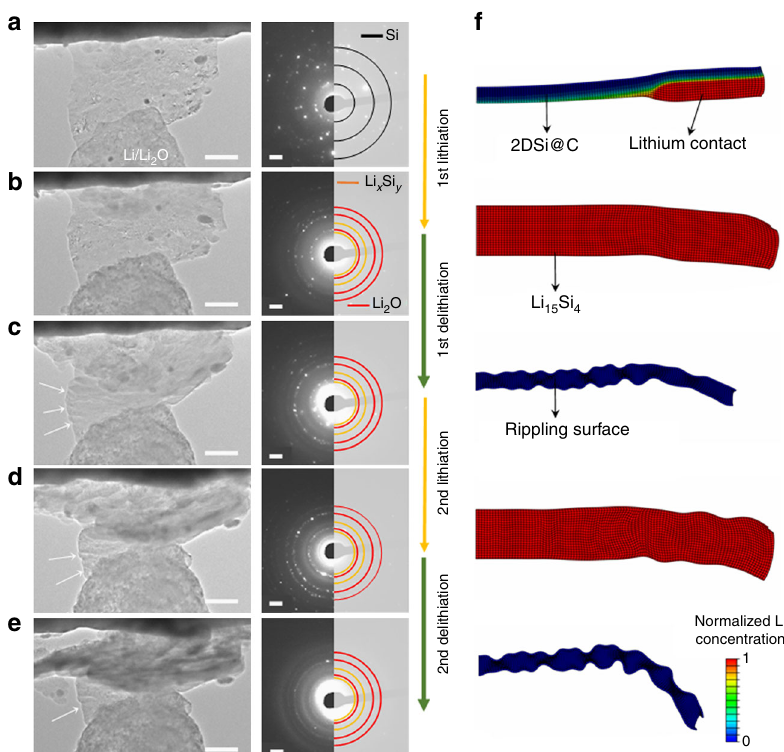
Fig. 2 Electrochemical and chemomechanical behavior of the 2DSi@C. a – e The time-lapse in situ TEM images and corresponding SAED patterns of 2DSi@C for two cycles of lithiation and delithation. f Snapshots of chemomechanical modeling of 2DSi@C corresponding to the in situ TEM results. Scale bars, 500 nm for TEM images and 2 1/nm for SAED patterns ( a – e